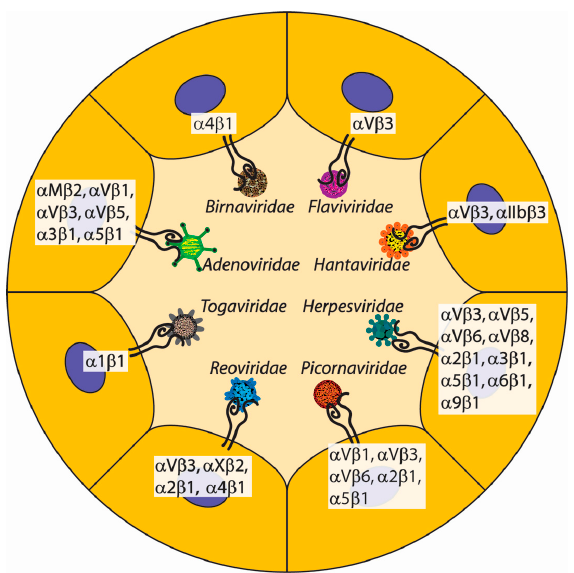
Figure 3. Viruses hijack integrins for adhesion and infectivity. Virus families use specific integrins in order to adhere to target cells for the purposes of internalization and infectivity. Members of the family Adenoviridae are non-enveloped viruses with icosahedral capsids that have penton base structures which facilitate RGD-dependent docking with α V β 1, α V β 3, α V β 5, and α 5 β 1 integrins as well as the RGD-independent engagement of α 3 β 1. Adenoviruses also target α M β 2 integrin through an undetermined mechanism. Birnaviridae contains members who employ a fibronectin-mimicking IDA peptide to bind α 4 β 1 integrin. Members of the Flaviviridae family have an RGD-containing E-protein which binds α V β 3 integrin. Viruses in the family Hantaviridae target the plexin-semaphorin-integrin (PSI) domain of α V β 3 and α IIb β 3 integrins. Herpesviridae has members that employ a few different mechanisms of integrin engagement for the purposes of viral entry. The envelope protein BMRF-2 contains an RGD sequence that docks α 5 β 1 integrin. The envelope proteins gH and gL dock with α V β 5, α V β 6, and α V β 8. Another envelope protein, known as gB, contains both an RGD motif and disintegrin-like domain, which affords viral targeting of α V β 3, α V β 5, α 2 β 1, α 3 β 1, α 6 β 1, and α 9 β 1 integrins. Members of the Picornaviridae family use capsid proteins to target integrins. The targeting